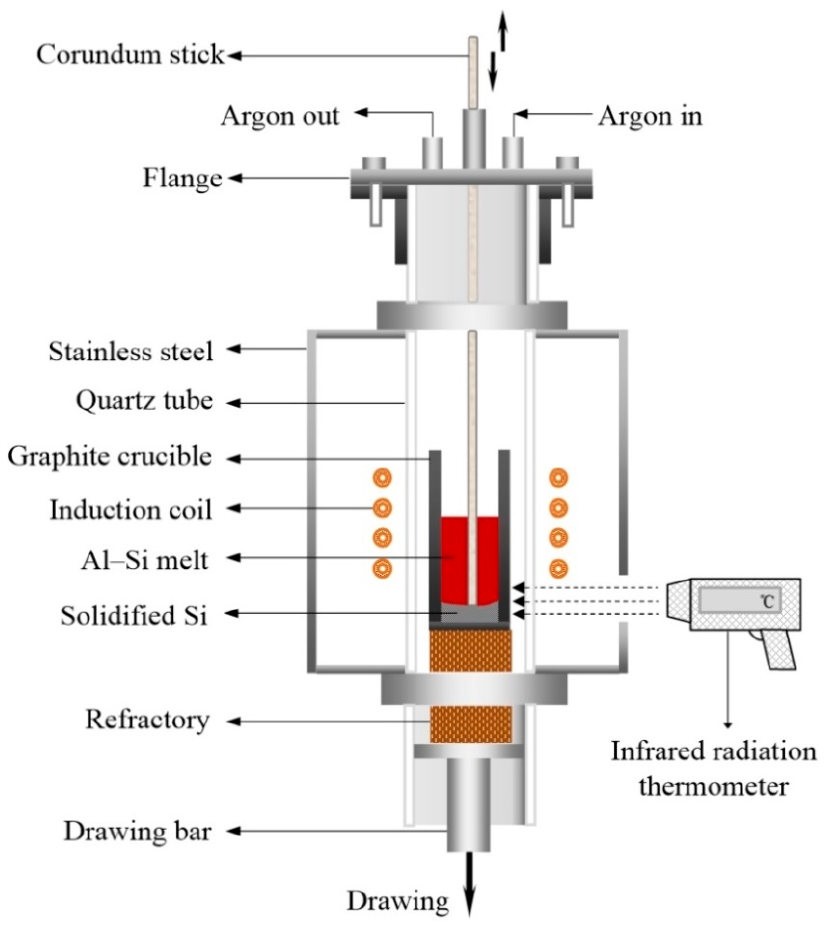
Figure 1. Schematic of the electromagnetic directional solidification setup.